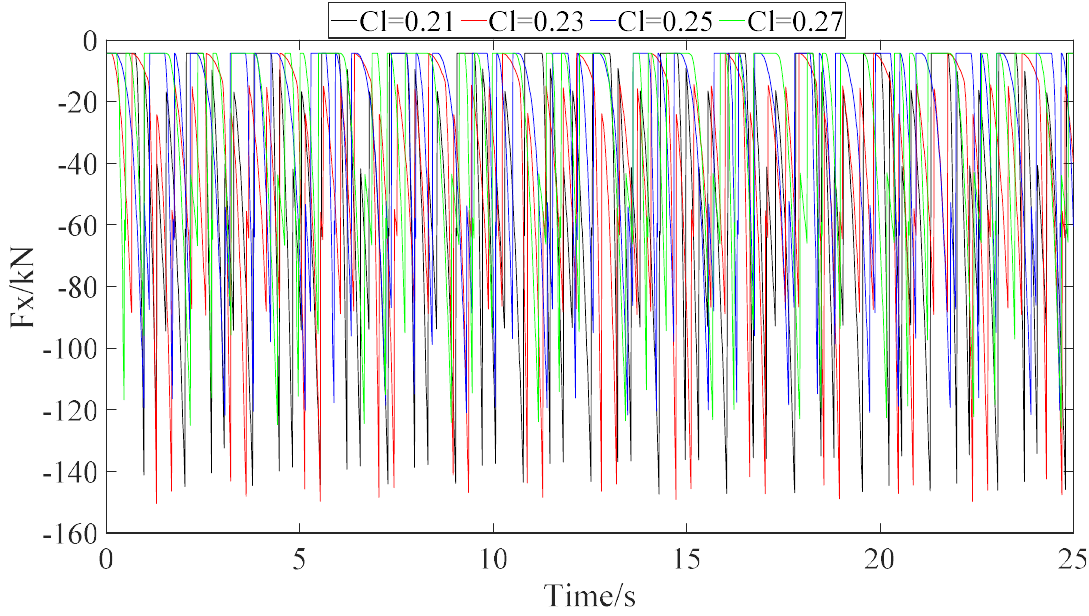
Figure 10. Time history curves of total ice force under different length coefficients ( C l ). Fast Fourier transform (FFT) is applied to get the corresponding frequency domain for simulated curves in Figure 10. The results are shown in Figure 11. It can be seen from the figure that large peaks all appear in the low frequency region, and the frequency difference between the peaks is basically equal. The reason for this situation is that the ice field has been pre-processed into square ice blocks. During the advance of the hovercraft, the ice blocks break periodically. Therefore, the frequency of peaks in this program is related to the length of the ice block. The ice length coefficient affects the length of the ice